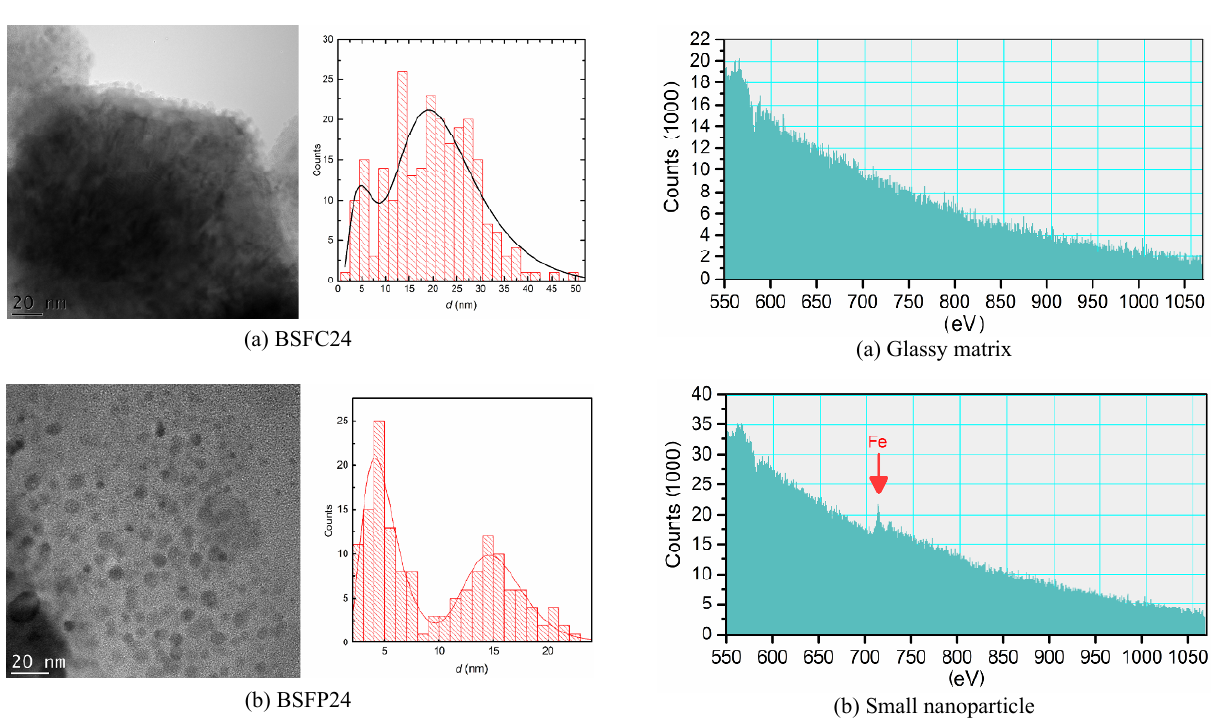
Fig. 3 EELS spectra taken on the BSFC24 sample.